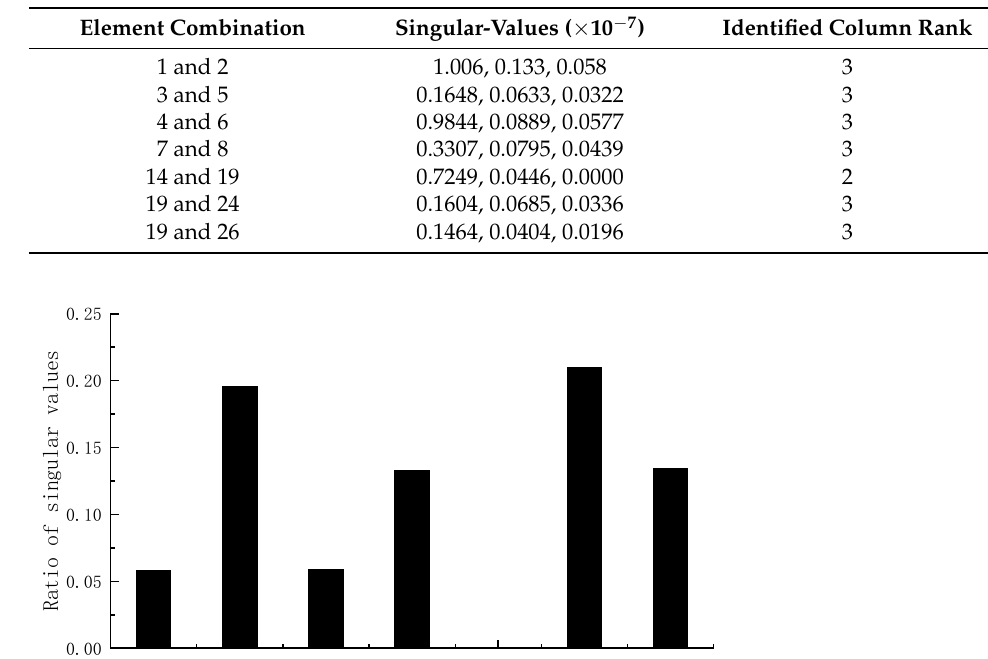
Table 4. The singular-values of the flexibility correlation matrix for some element combinations.